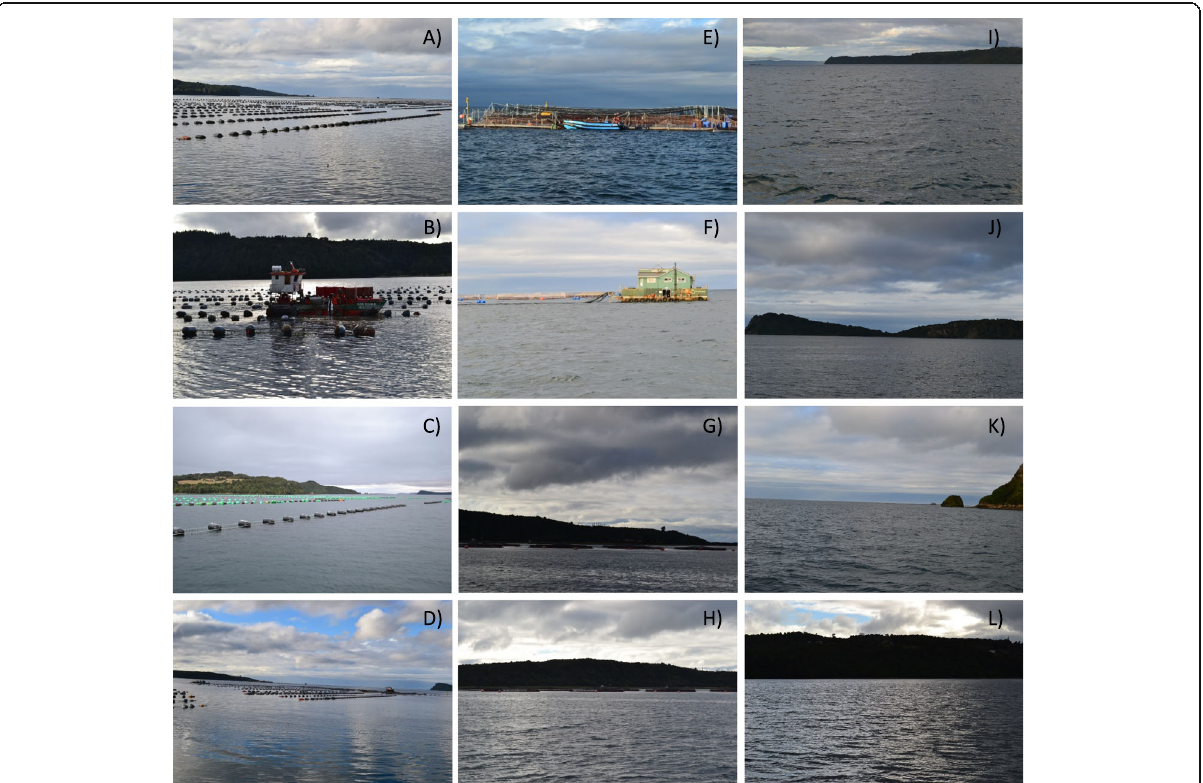
Fig. 2 Photographs of Caucahue Channel showing gradients of distances from active aquaculture farms and surrounding areas of references sampling sites. a - d Q sites near and far from active mussel farms, e - h )Q sites near and far from active salmon farms, i - l C references sites far from active aquaculture